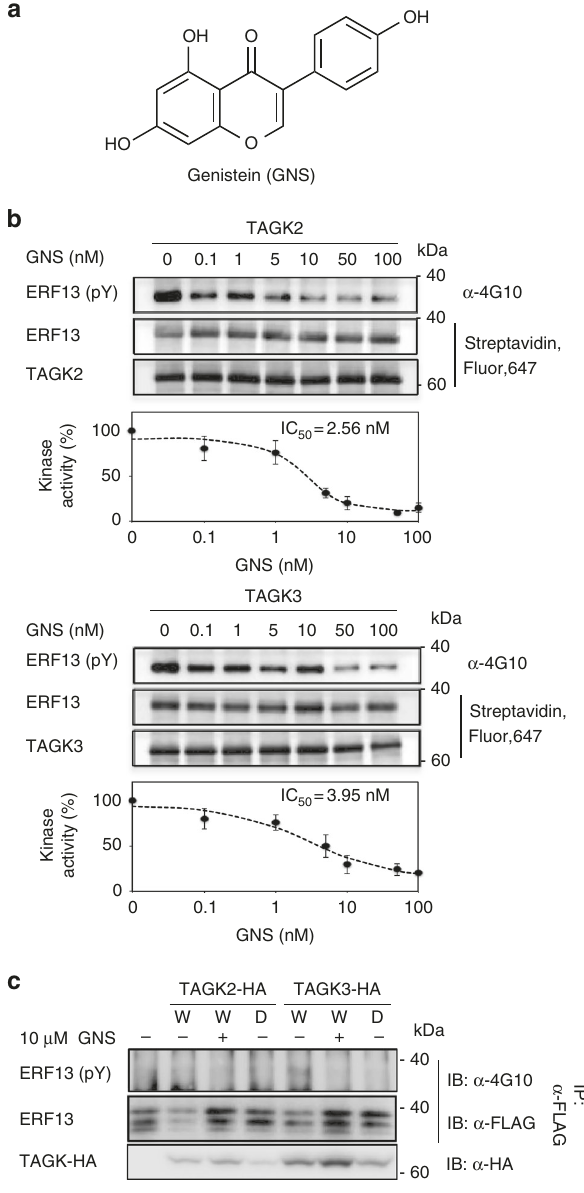
Fig. 3 TAGK activities are inhibited by GNS. a Structures of GNS. b In vitro inhibition assay of TAGKs by GNS. Tyr phosphorylation (pY) was detected by anti-phospho-Tyr antibody (4G10) (upper panel). Concentration- inhibition curves for GNS were quanti fi ed from at least three independent in vitro kinase assays (lower panel). Data are means ( ± s.d.) of three independent experiments ( n = 3). ERF13 is substrate for TAGK2 and TAGK3. c Tyr phosphorylation analysis of ERF13 in protoplasts. FLAG-ERF13 was co-expressed with TAGK2-HA or TAGK3-HA (wild-type, W; kinase dead, D) in protoplasts. After incubation with 10 µ M GNS or 0.1% DMSO (control) for 24 h, FLAG-ERF13 was immunoprecipitated using an anti- FLAG antibody agarose beads form protoplasts lysates. Tyr phosphorylation (pY) was detected by 4G10 antibody. Expression of TAGK2-HA and TAGK3-HA was detected by anti-HA